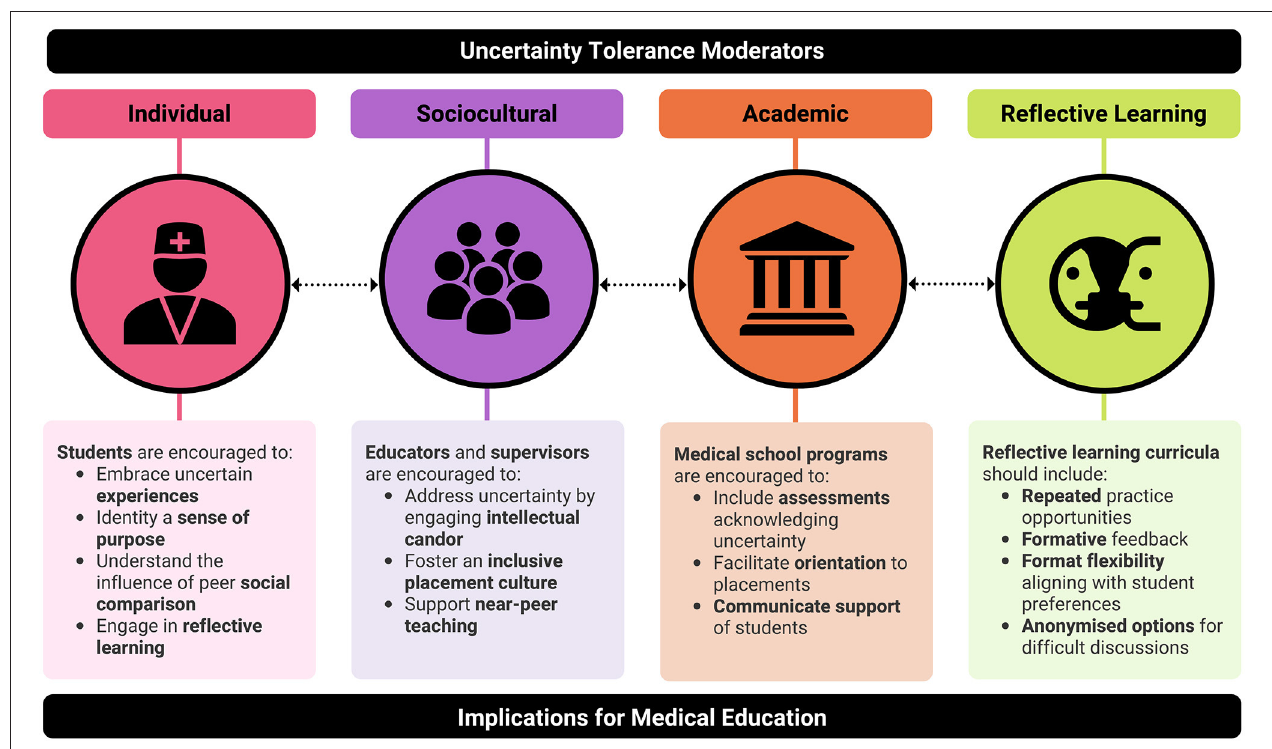
FIGURE 2 | Uncertainty tolerance (UT) moderator themes and suggested translations to clinical education. Dotted arrows between themes indicate that successful development of medical students’ UT should ideally involve interventions that cut across all aspects of medical education.